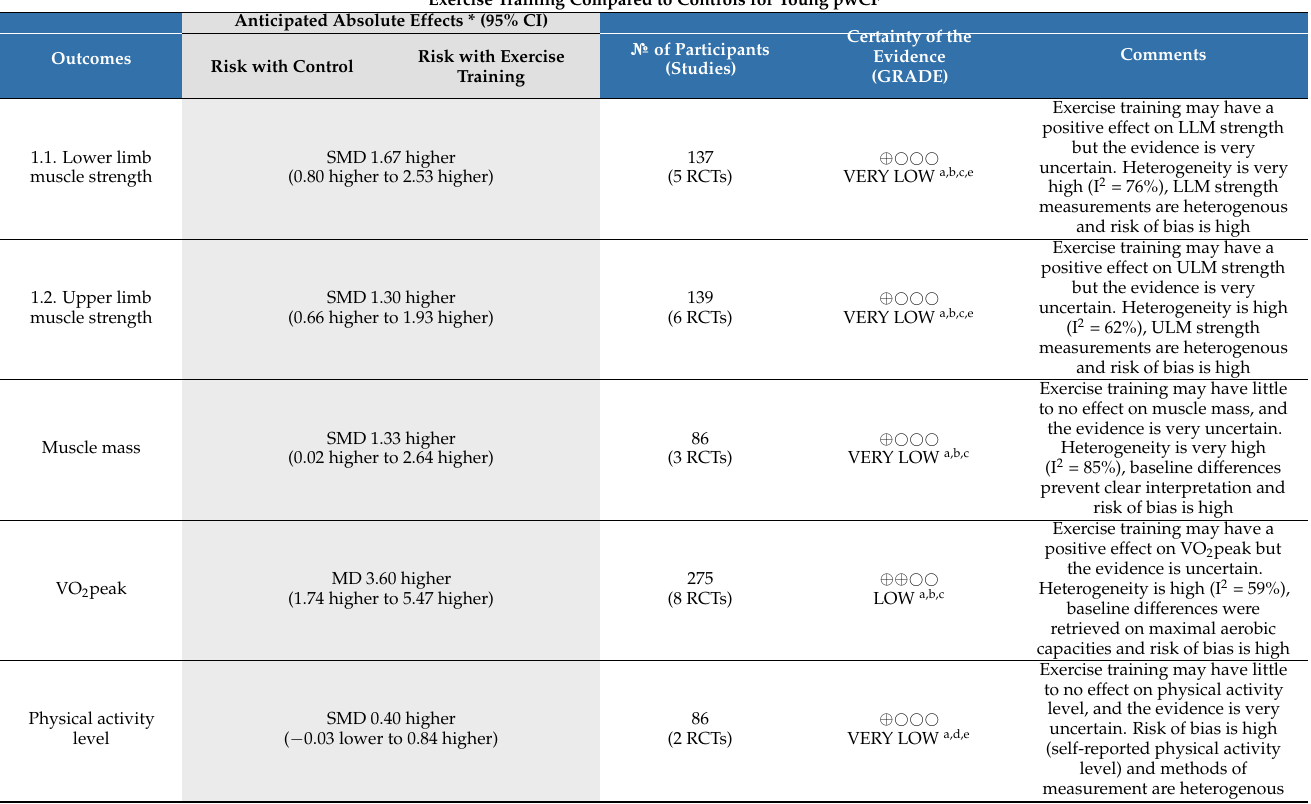
Table 2. GRADE Summary of